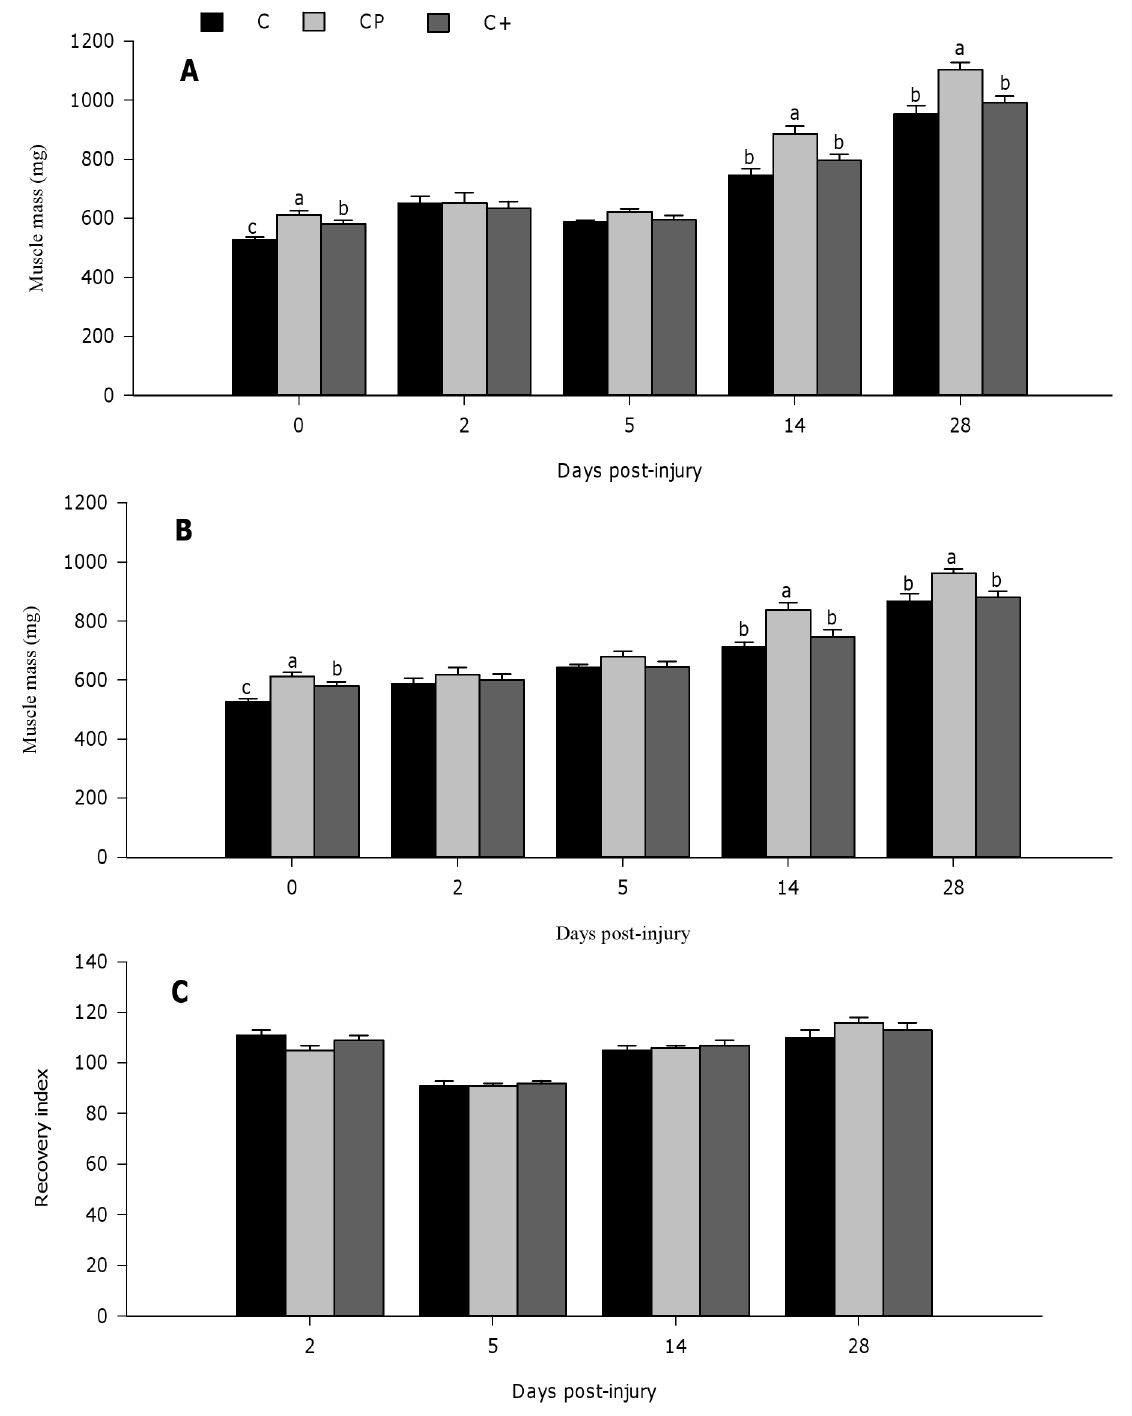
Figure 2. Muscle mass recovery of regenerating tibialis anterior muscle in rats. Both sham and bupivacaine-injured muscles were collected at days 0, 2, 5, 14, and 28 post-injury, and weighed. Muscle weights are presented for injured (A) and sham (B) muscles. A recovery index, as the percentage of injured relative to sham values, was calculated and presented for muscle mass (C). Values are mean ± SEM (n = 7-8 rats per dietary group/time point). Groups bearing different letters for a given time point are significantly different (p≤0.05). C, casein; CP, cod protein; C + , casein supplemented with L-arginine, glycine, L-taurine and L-lysine.